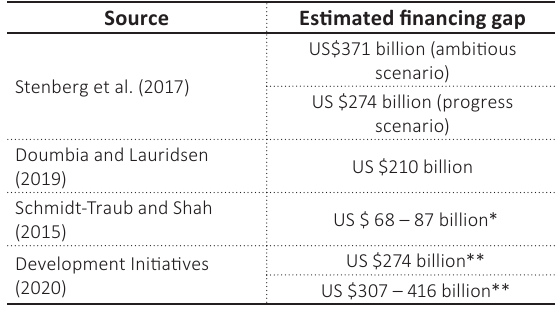
Table 1. Estimated additional spending per year on health required by 2030 to achieve progress within the SDG 3 health